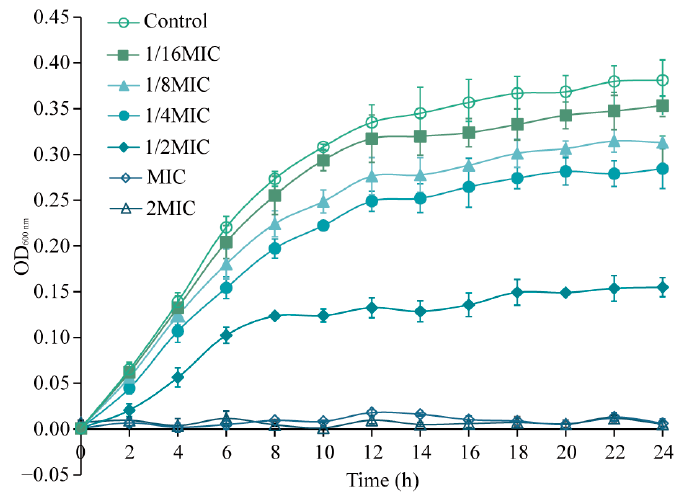
Figure 2. Growth curve analysis of Sh. flexneri with various concentrations of eugenol.